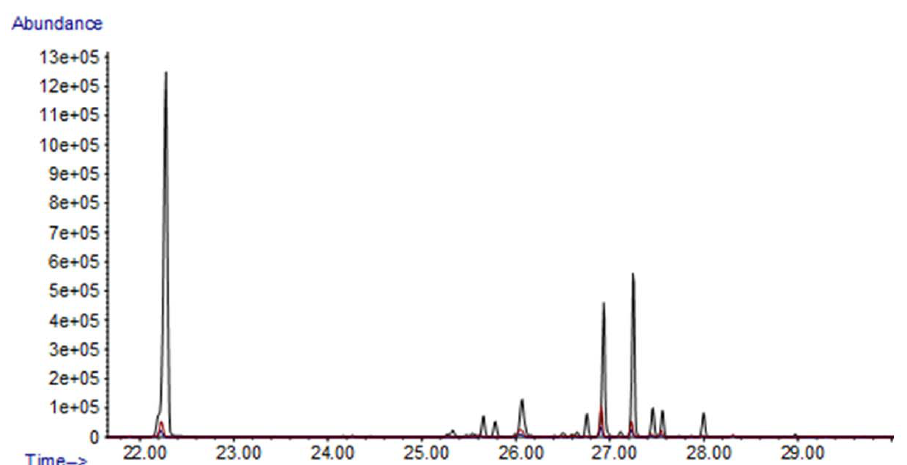
Figure 5. Pyrogram in extract ion m/z 217 characteristic of the saccharide compounds evidenced in black line for the SAB and in red line after irradiation at 1064 nm with a fluence of 2 J ∙ cm − 2 .